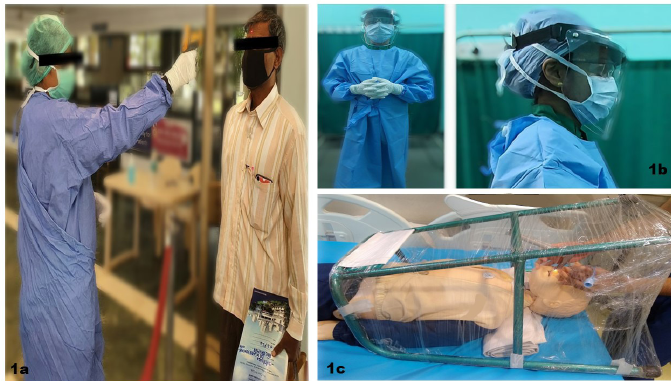
Figure 1. Hospital(s) prepared standards for patients admitted into the hospital during COVID-19